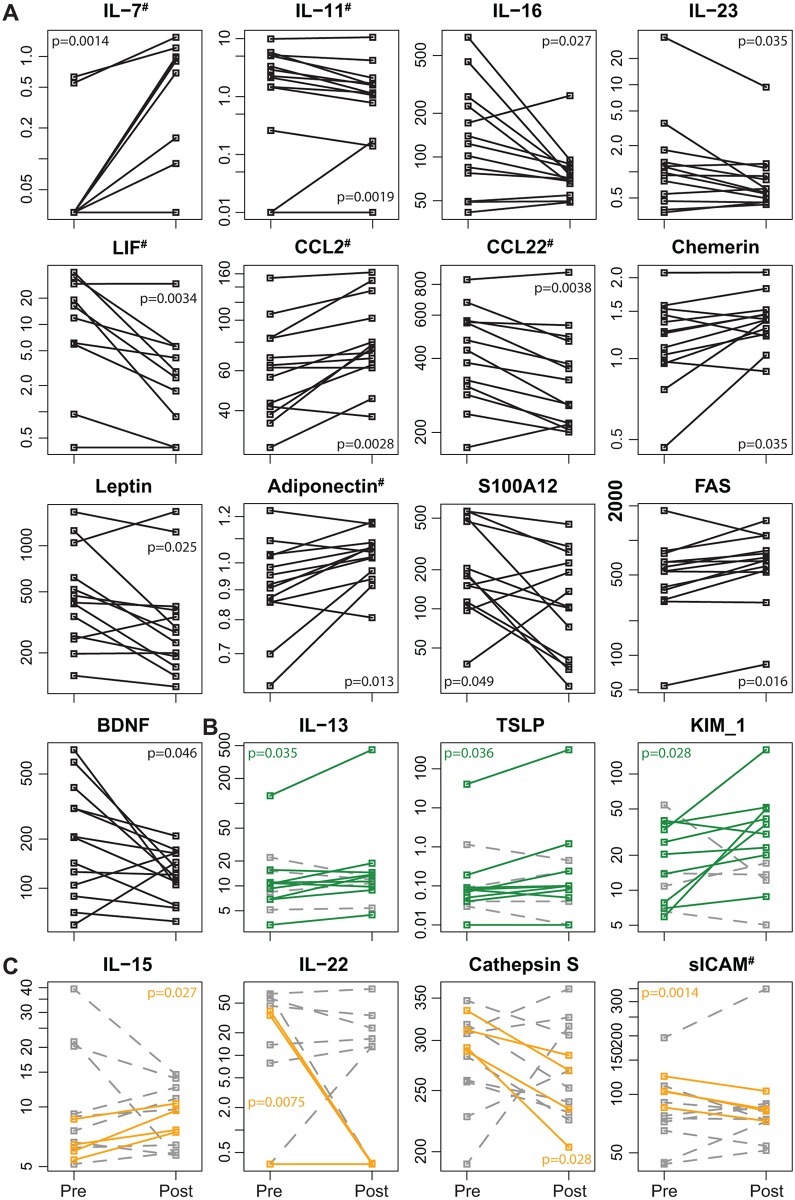
Serum markers changing by transplantation and immunosuppression.Serum marker levels that significantly change from pre islet cell transplantation to one year post transplantation are depicted (Student’s t-test, p<0.05): for all patients (A), for patients with good engraftment (B, green) and for patients with insufficient engraftment (C, orange). Serum levels are in pg/ml for: IL-7, IL-11, IL-13, IL-15, IL-16, IL-22, LIF, TSLP, CCL2, FAS, BDNF, KIM-1; ng/ml for: IL-23, CCL22, Cathepsin S, sICAM, S100A12; in ug/ml for: Chemerin, Leptin; mg/ml for: Adiponectin. Samples out-of-range at both time points were excluded from statistical analysis.